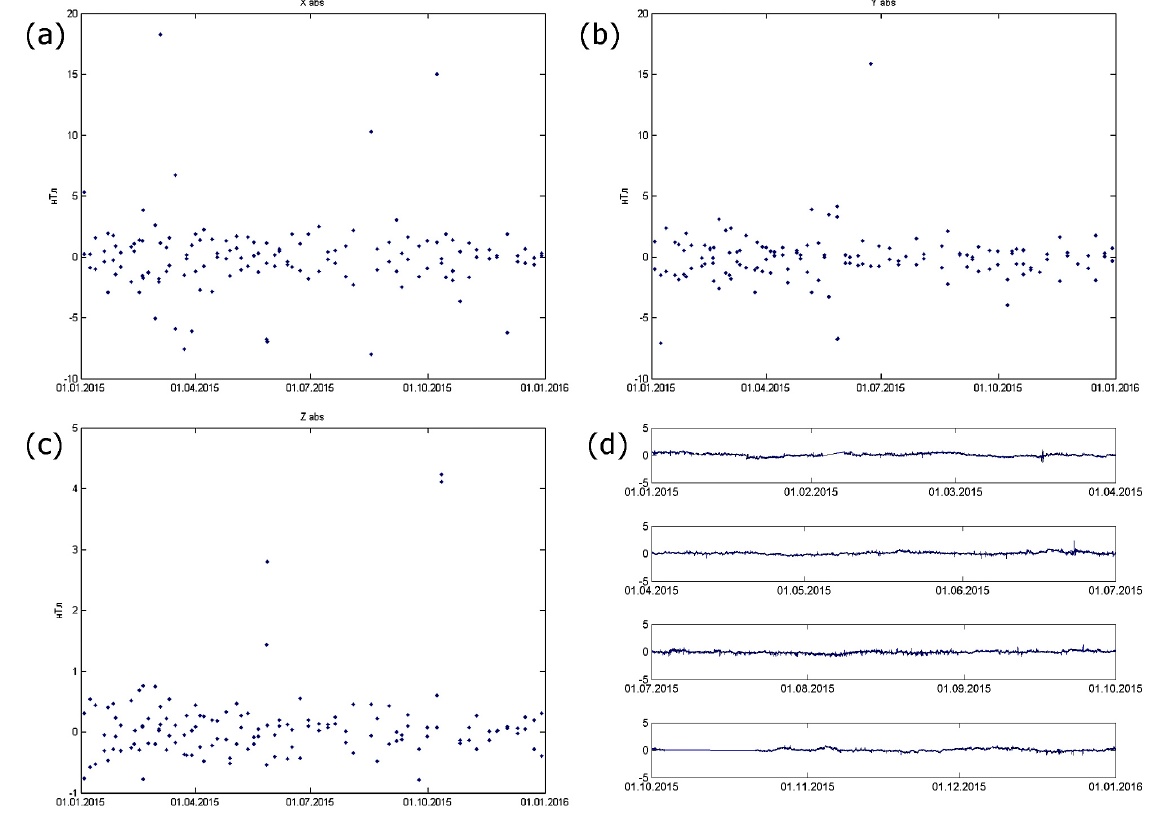
Figure 10. Differences in the absolute measurements of the magnetic field components and definitive 1min values taken for the corresponding time moments: X component (a) , Y component (b) , Z component (c) , and fragments of the (cid:49)F record over 2015 (d)